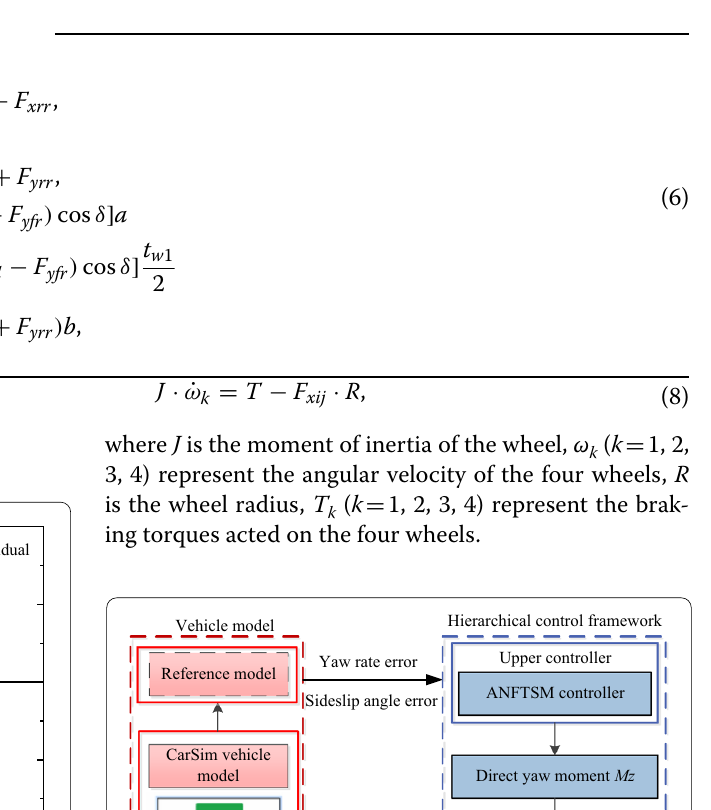
CarSim vehicle model